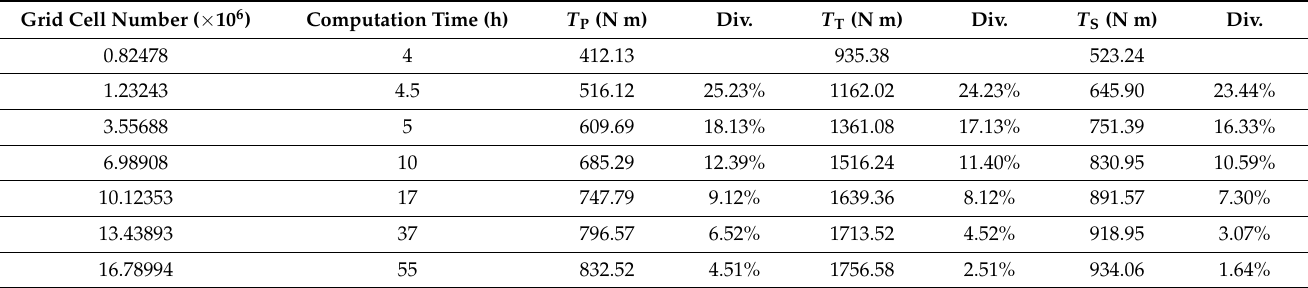
Figure 3. Verification of grid independence. Figure 3. Veri fi cation of grid independence. Table 3. Mesh independence study Table 3. Mesh independence study results.